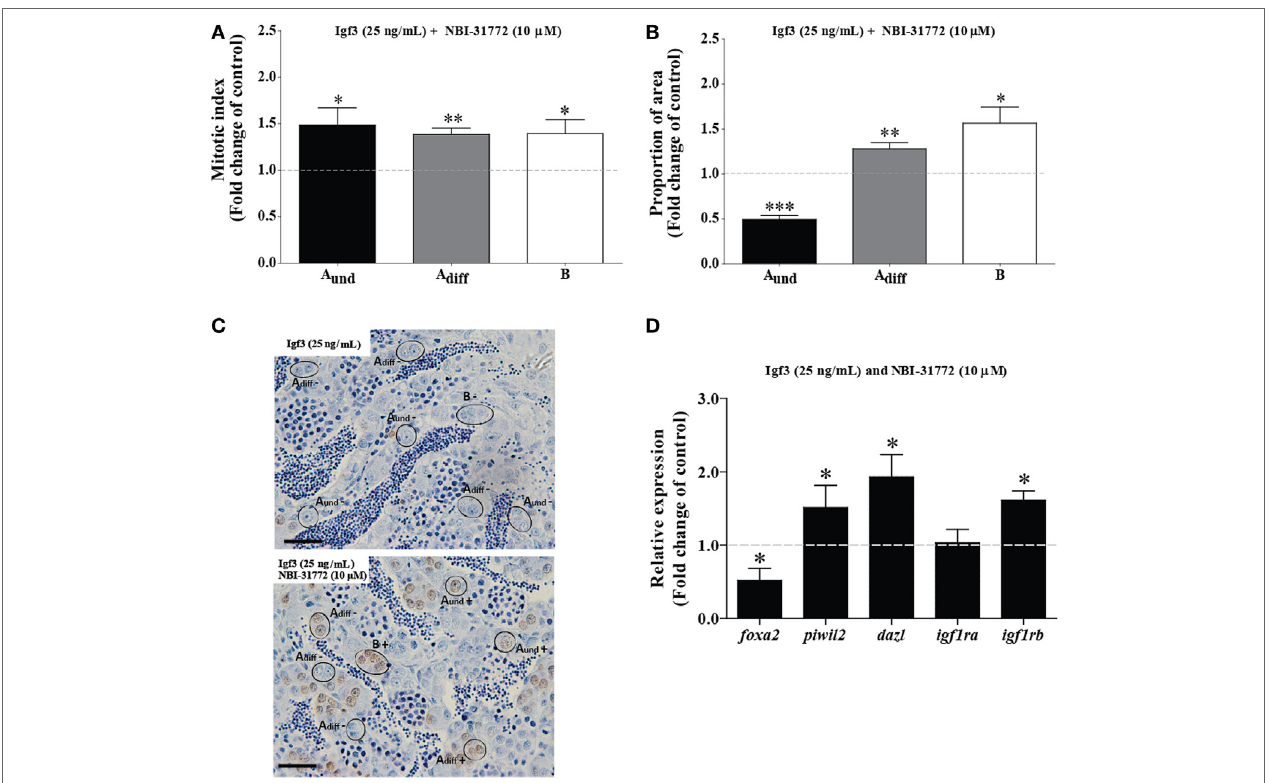
FigUre 5 | Effect of 25 ng/mL Igf3 in the presence of an IGF-binding protein inhibitor on spermatogonial proliferation and proportion of area after 3 days of primary testis tissue culture. (a) Mitotic indices of type A und , type A diff , and type B spermatogonia in the presence of Igf3 alone (25 ng/mL) (dotted line; control condition) or in combination with 10 µM NBI-31772 (bars) ( n = 6). (b) Proportion of section surface area occupied by cysts containing type A und , type A diff , or type B spermatogonia in the presence of Igf3 alone (25 ng/mL) (dotted line; control condition) or in combination with 10 µM NBI-31772 (bars) ( n = 6). (c) Immunocytochemical detection of BrdU in sections of zebrafish testis incubated with 25 ng/mL alone (upper panel; control condition) or in combination with 10 µM NBI-31772 (lower panel) for 3 days showing BrdU positive ( + ) and negative ( − ) A und , A diff , and B spermatogonia. Bars, 25 µm. (D) Gene expression analysis in adult zebrafish testis after 3 days of tissue culture in the presence of Igf3 (25 ng/mL) (represented by a dotted line) or in combination with 10 µM NBI-31772 (bars) ( n = 7). Results are presented as fold changes with respect to the control group (25 ng/mL Igf3). Asterisks indicate significant differences (* P < 0.05; ** P < 0.01; *** P < 0.001) between